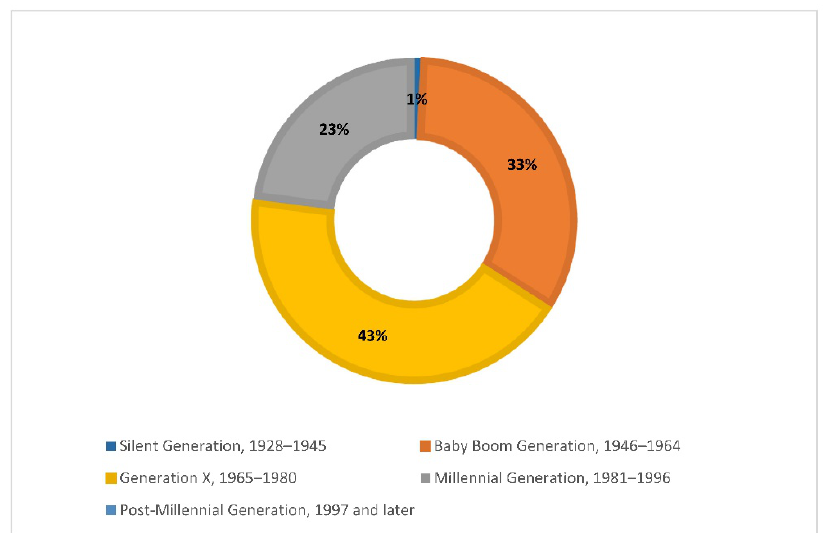
Figure 1 Survey respondents’ self-identified generational